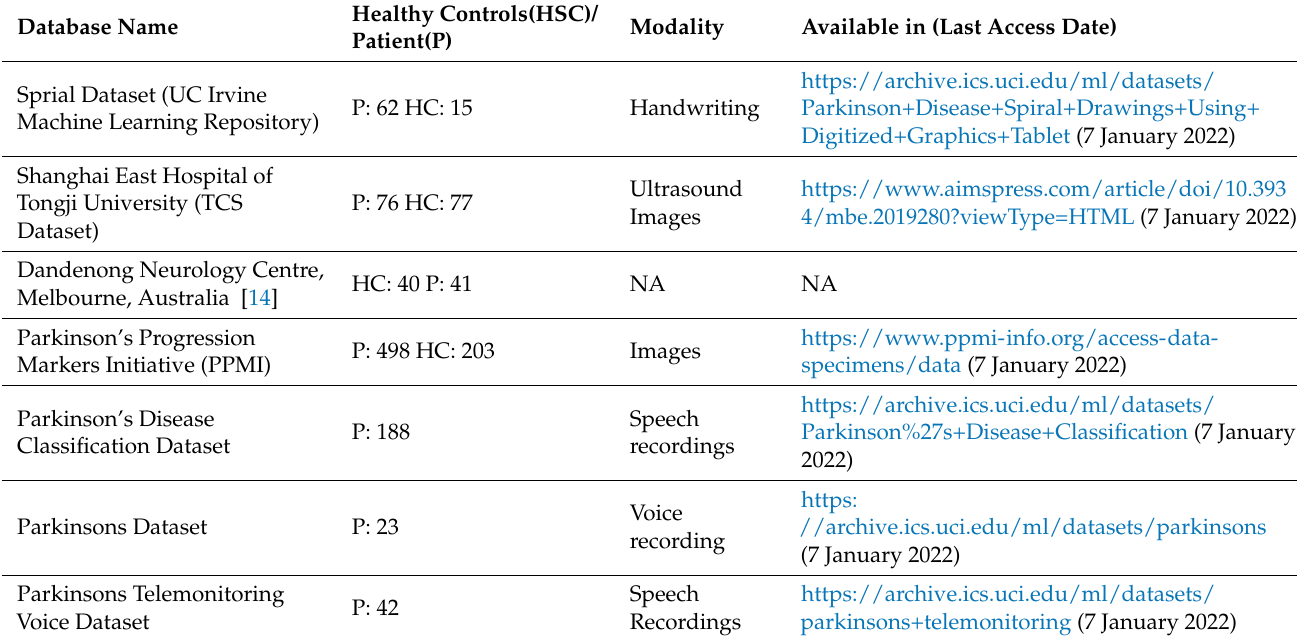
Table 3. A tabulation of popular datasets of Parkinson’s disease.